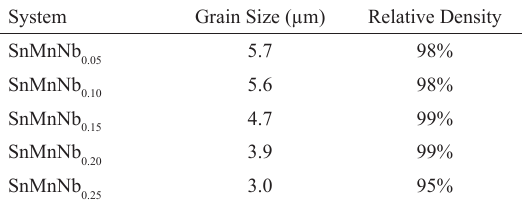
Figure 1. FEG-SEM images of varistor system (99.5-X) SnO (0.5) MnO - (X) Nb O , with the following X content: A) 0.05%; 2 2 5 B) 0.10%; C) 0.15%; D) 0.20% and E) 0.25%. Table 1. The calculated average grain size for each varistor system studied.